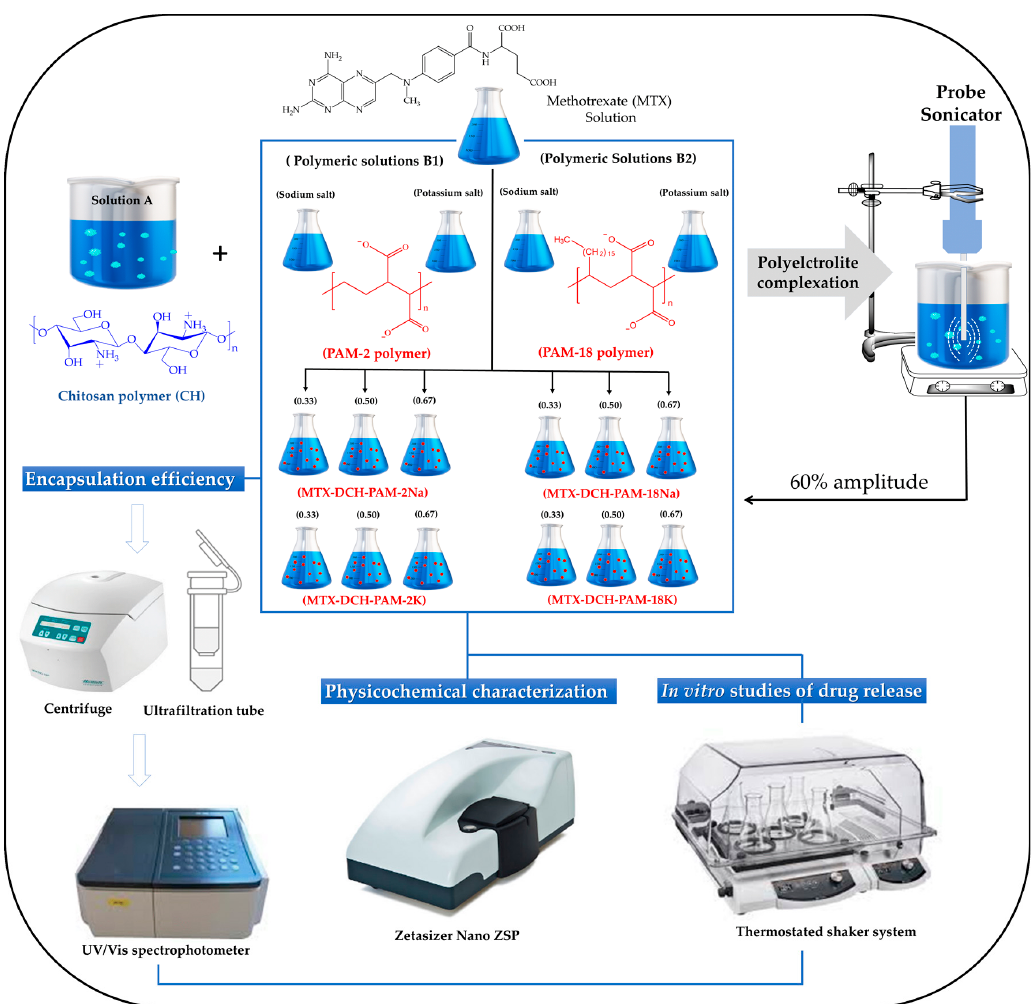
Figure 1. Schematic of the formation of chitosan–polyanion nanoparticles unloaded and loaded with methotrexate, using high-intensity ultrasound. The sodium and potassium counterions are not shown in the scheme.